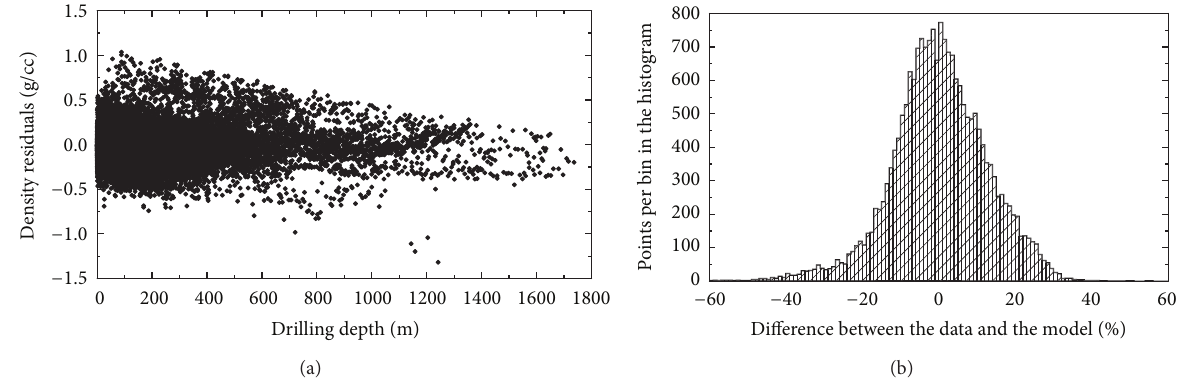
Figure 7: Errors of the 3D sediment density model in (3). Scatter plot and histogram of the differences between the measured and theoretical density values. The density differences are plotted with respect to the sediment depth. Statistics of the differences: standard deviation = 0.22 g/cm 3 , max = 1.04 g/cm 3 , and min = − 1.32 g/cm 3 . The histogram shows the relative distribution of the density